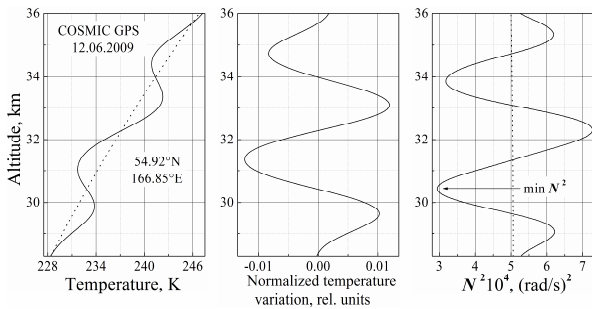
Figure 4. Wavelike temperature oscillations in the middle latitudes of the Earth’s atmosphere Fig. 4. Wavelike temperature oscillations in the middle latitudes observed from the vertical temperature profile retrieved from the COSMIC GPS radio of the Earth’s atmosphere observed from the vertical tempera- occultation on 12 June 2009. Description of panels is the same as in Fig. 1. 5 ture profile retrieved from the COSMIC GPS radio occultation on 12 June 2009. Description of panels is the same as in Fig.